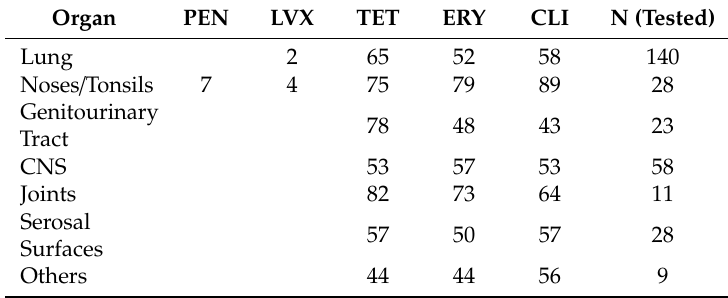
Table 3. Frequency of resistant S. suis isolates in the relation to the tissue location [%] *. Organ PEN LVX TET ERY CLI N (Tested)